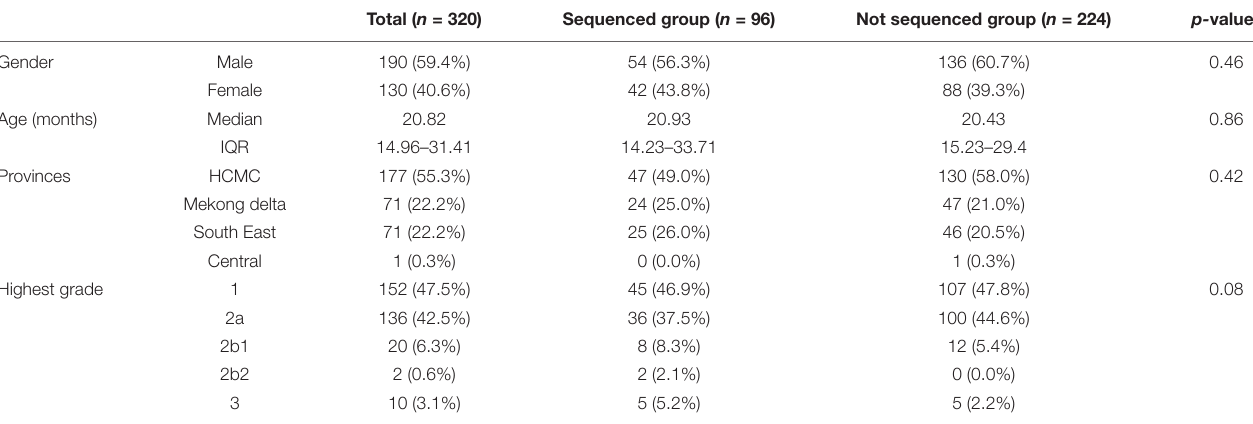
TABLE 1 | Demographic information and clinical grades of CVA16 cases in Vietnam